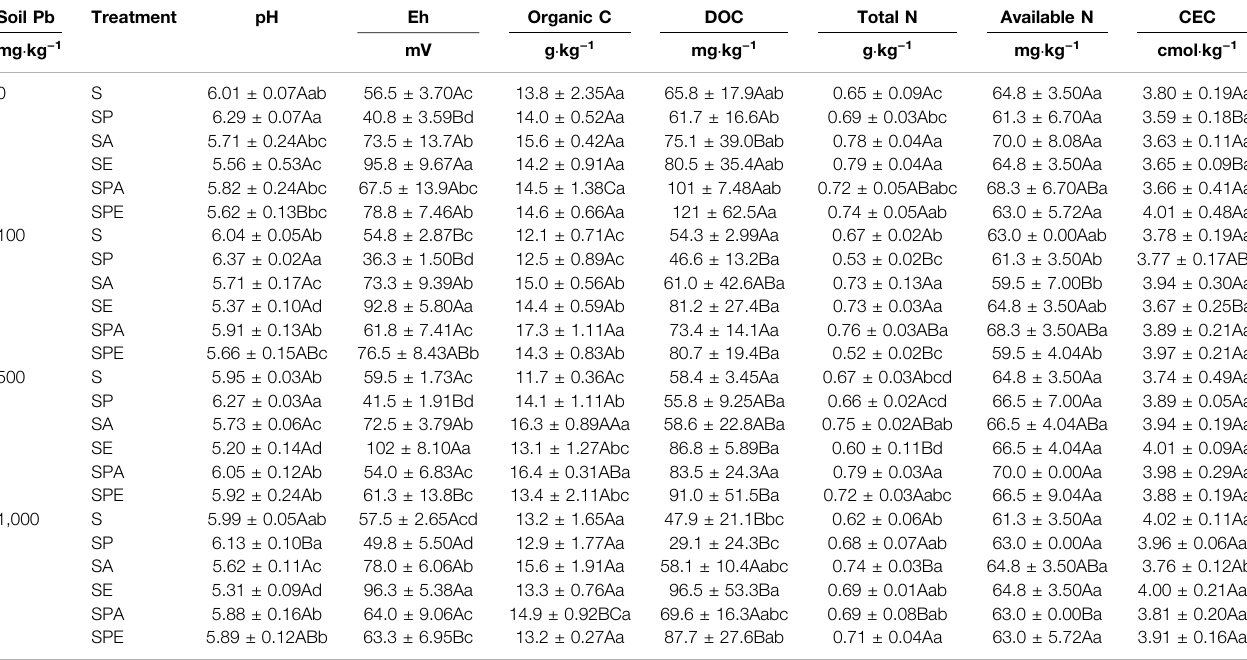
TABLE 2 | Effects of earthworm inoculation and plant growth on soil chemical properties under different Pb contamination conditions. Soil Pb Treatment pH Eh Organic C DOC Total N Available N